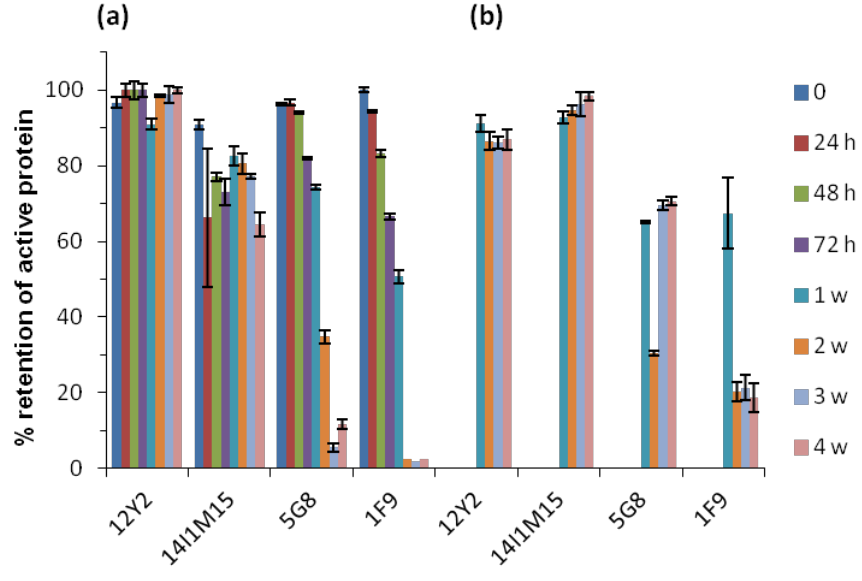
Figure 3. Retention of active V 12Y-2 and 14I1M-15, and monoclonal antibodies NARs (mAbs) 5G8 and 1F9 following heating at 45 °C in ( a ) liquid and ( b ) lyophilized formats, as determined by biosensor analysis. The standard deviation for 1F9 time points 2, 3 and 4 weeks was ≤30%, error bars are shown for all other